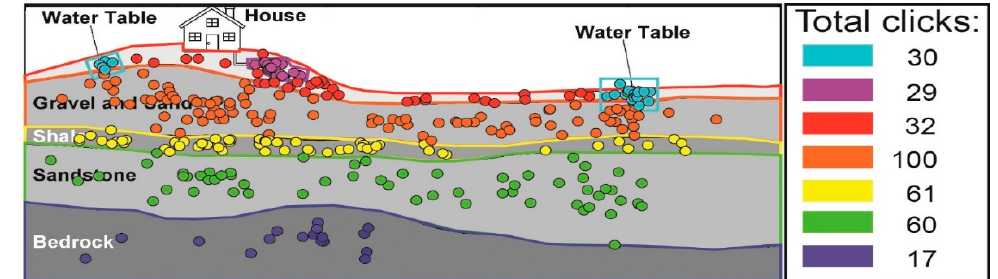
Figure 3. Polygons and student clicks in response to the prompt, “Click on the layer that represents the confined aquifer”. The correct region is labeled in green ( n = 60), with other colors associated with distinct structures in the diagram (e.g., confining layer—yellow, septic tank—purple)